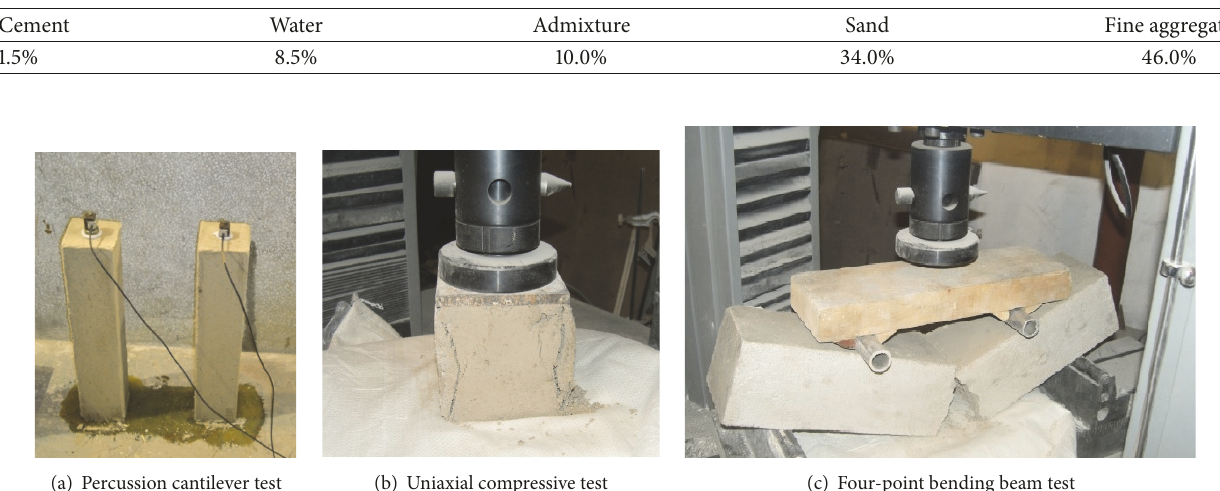
Table 2: Quality mixture ratio for the fine aggregate model material [28].